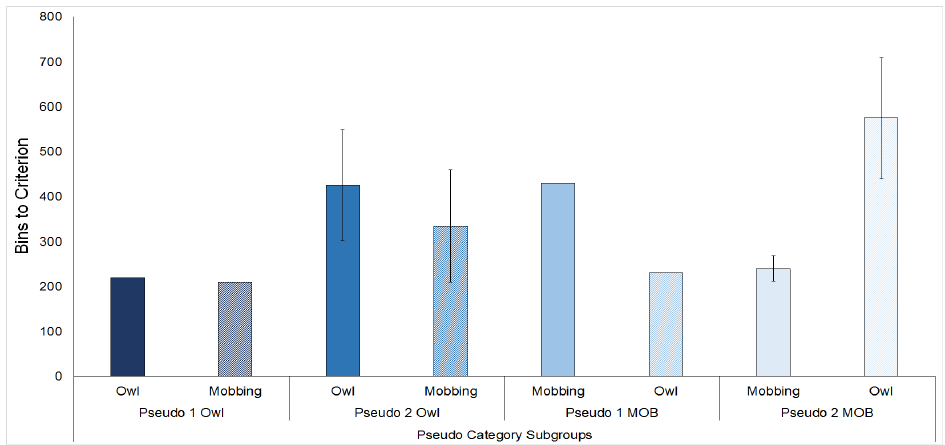
Discrimination Training II vs. Discrimination Training I: Pseudo Category